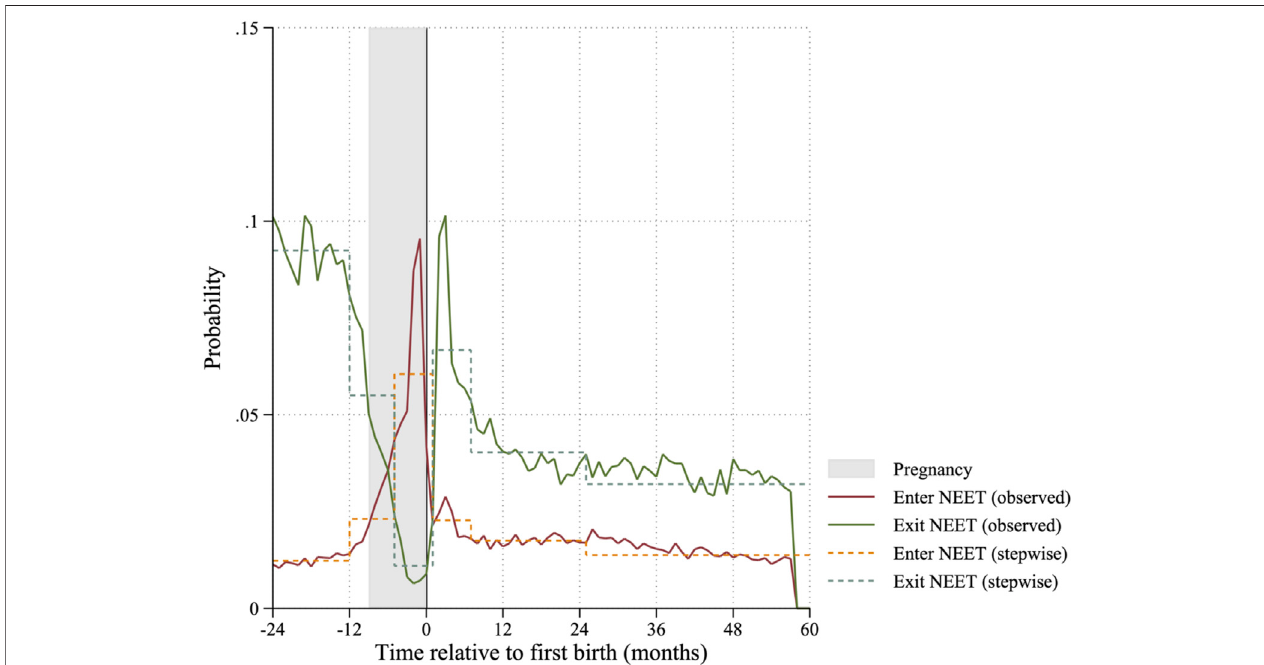
FIGURE 1 | Probabilities and step functions of entering and exiting NEET around the time of fi rst childbirth.